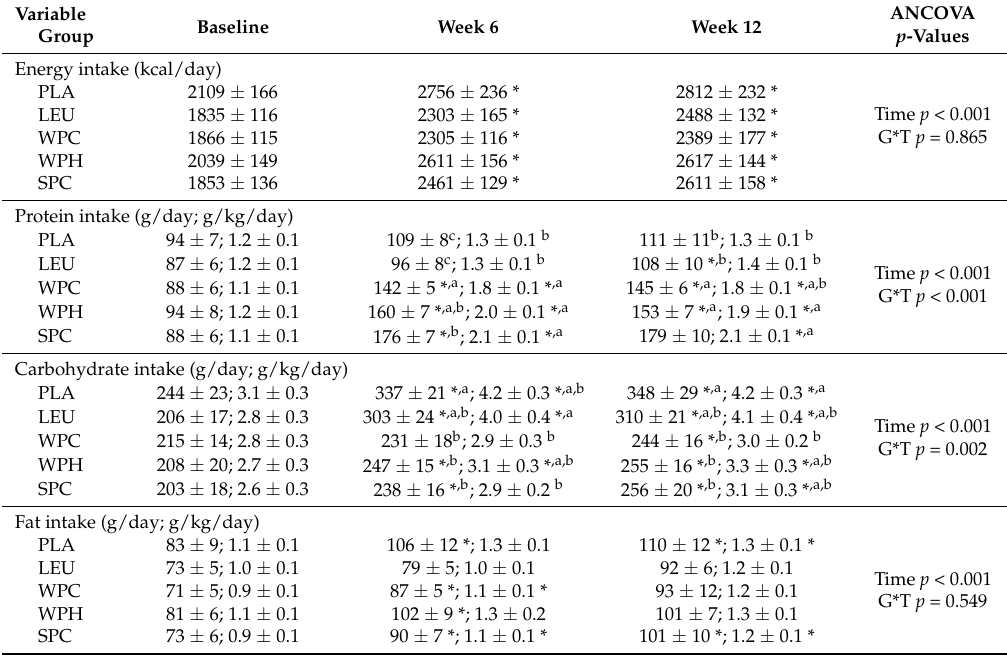
Table 4. Self-reported nutrient intakes between